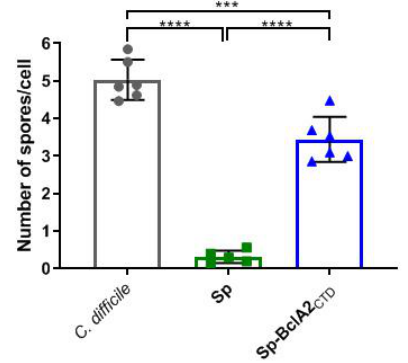
Figure 5. Adherence of spores to human intestinal cells. Caco-2 cells were differentiated for 8 d and infected with spores of C. difficile R20291 , B. subtilis (Sp), and B. subtilis spores adsorbed with BclA2 CTD (Sp-BclA2 CTD ). The number of adhered spores and cells was counted in 10 microscopic fields on phase-contrast microscopy. The data represent the mean of three independent experiments, and the error bars are the standard error of the mean. The groups were compared with one-way ANOVA Turkey’s multiple comparison test, and statistical differences ( p < 0.05) are indicated by asterisks.